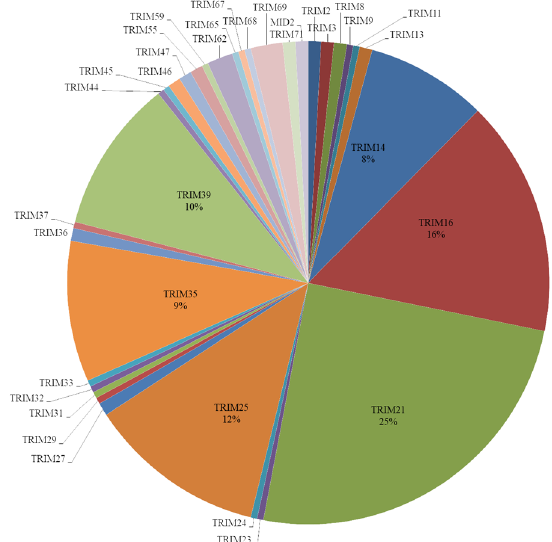
Fig. 7 Distribution of gene numbers in the TRIM gene family in yellowstripe goby. A total of 34 TRIM gene families (234 members) were identi fi ed in yellowstripe goby, which is the largest number among known species (Supplementary Table 16), with TRIM14 , TRIM16 , TRIM21 , TRIM25 , TRIM35 , and TRIM39 being the most